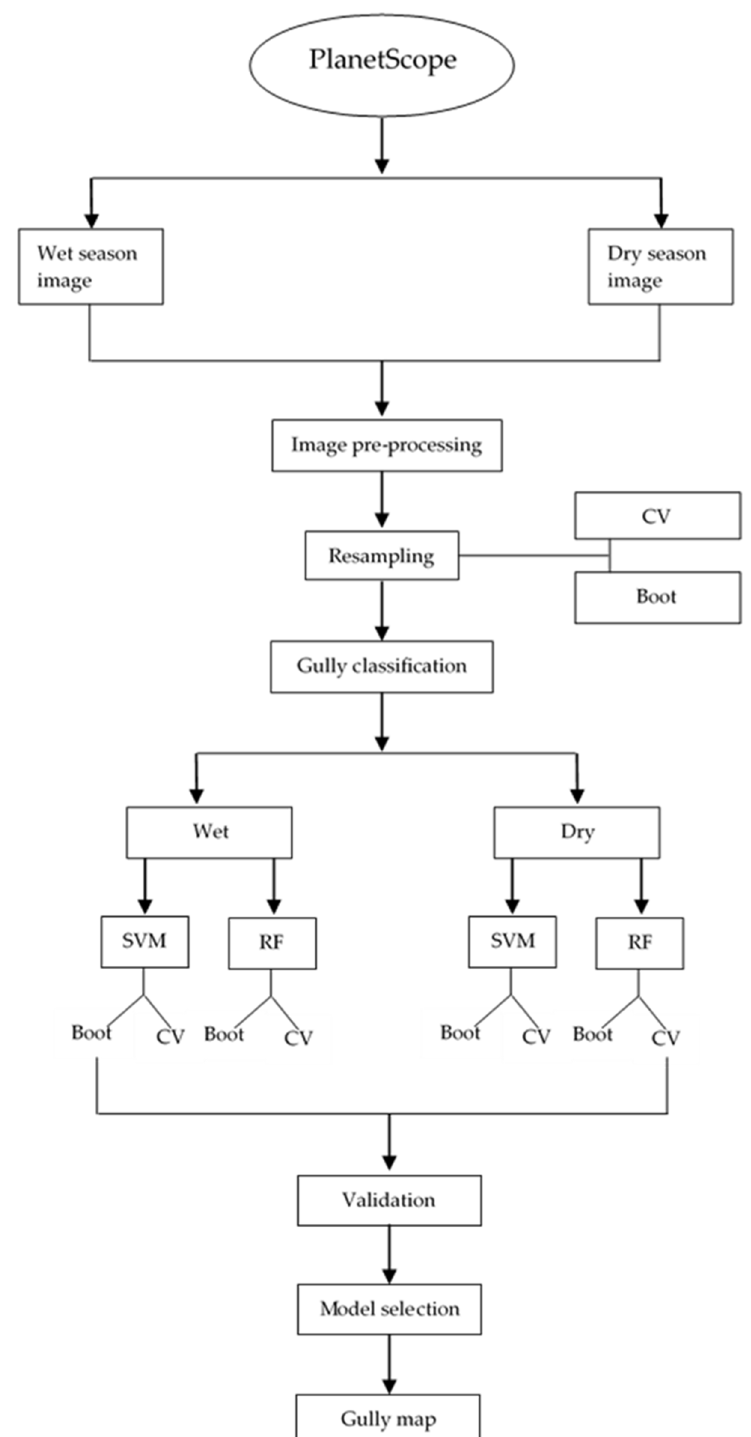
Figure 2. Workflow followed in this study (CV: cross-validation; boot: bootstrapping; SVM: support vector machines; RF: random forest).